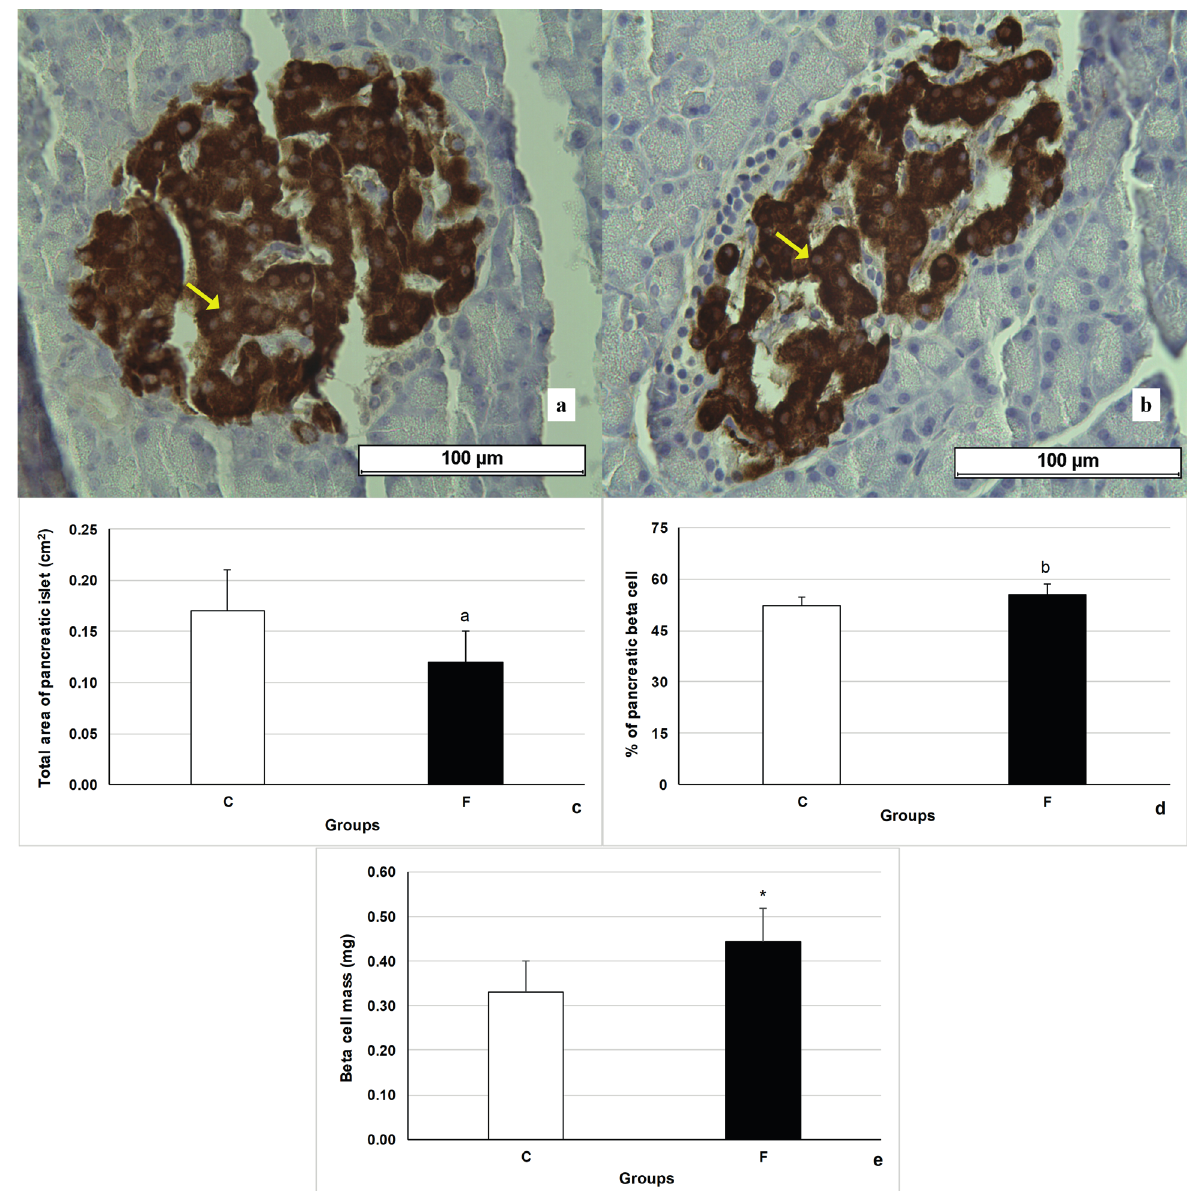
Figure 4 - Photomicrographs of insulin immunohistochemical staining of pancreatic islets. Section of the pancreas of the control group ( a ) showing strong immunoreactivity of insulin in beta cells (arrow), which occupy most of the islet. Pancreas of fructose group ( b ) showing marked reduction in the islet area and increased number of insulin-stained beta cells (IHC by anti-insulin antibodies, magnification x 400). Total area of pancreatic islet ( c ) from control and fructose groups. Percentage of pancreatic beta cells ( d ). Beta cell mass ( e ) stained with insulin from control and fructose groups. data shown as mean ± standard deviation (Sd). a p<0.05 - Gamma distribution. b p<0.05 - Binomial distribution. *p<0.05 – Student t